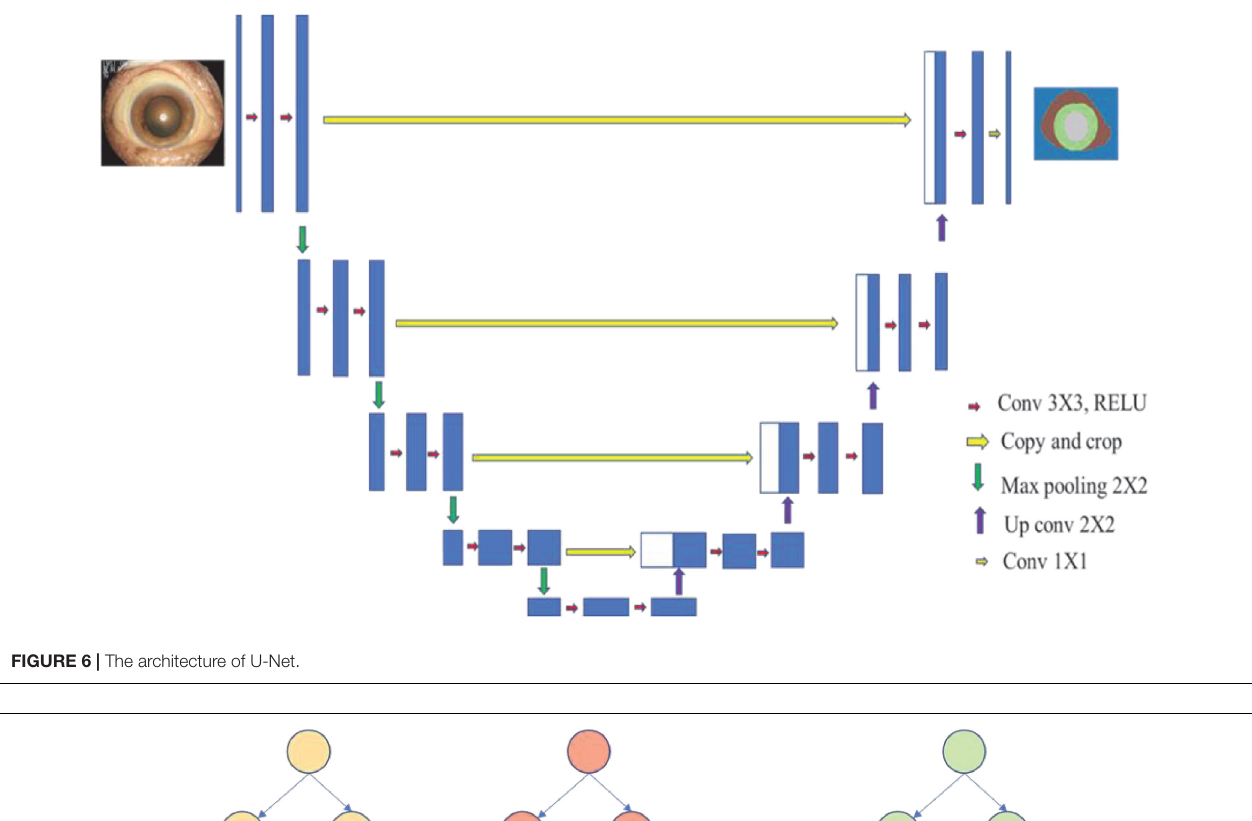
FIGURE 6 | The architecture of U-Net.